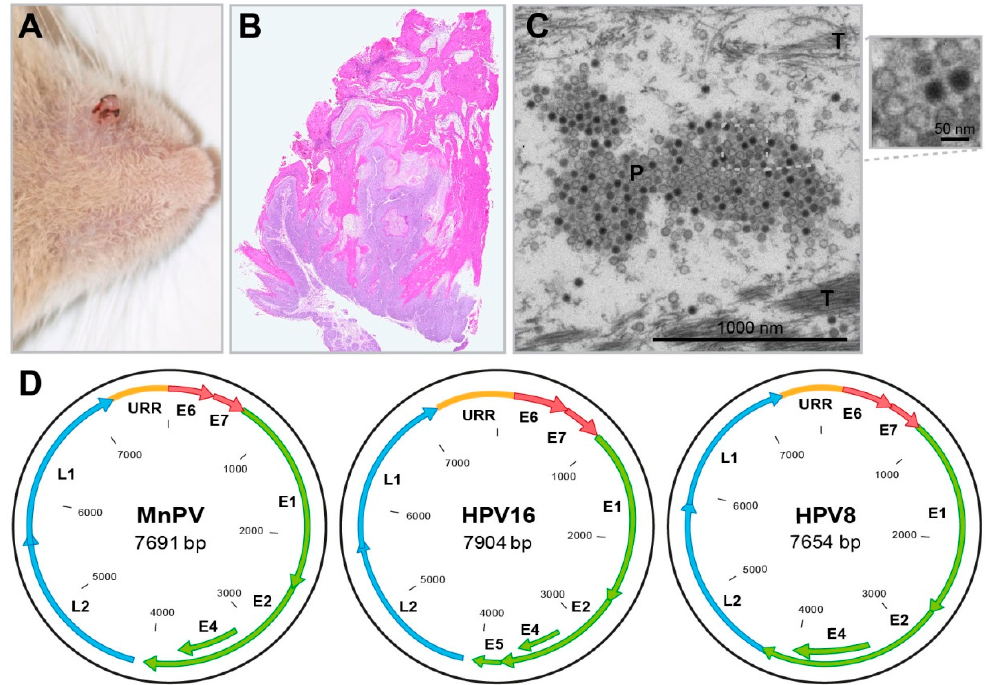
Figure 4. The Mastomys natalensis papillomavirus. ( A ) A spontaneous skin tumor (papilloma) near the nose. ( B ) HE staining of a spontaneous skin tumor (“so-called” keratoacanthoma) shows typical endo-exophytic growth and strong keratinization. ( C ) EM micrograph of MnPV particles (P) in the most upper layer of a spontaneous MnPV-induced skin lesion. While larger host cell compartments are already degraded during terminal differentiation and desquamation, tonofibrils (T) are still visible. ( D ) Schematic representation of the genomes of HPV16 (an alpha-type), HPV8 (a beta-type) and MnPV (an iota-type). While the genomes of all PV types harbor an upstream regulatory region (URR) and code for early genes (E1, E2, E4, E6, E7) and late genes (L1, L2), PVs from the genus beta and iota do not contain E5 open reading